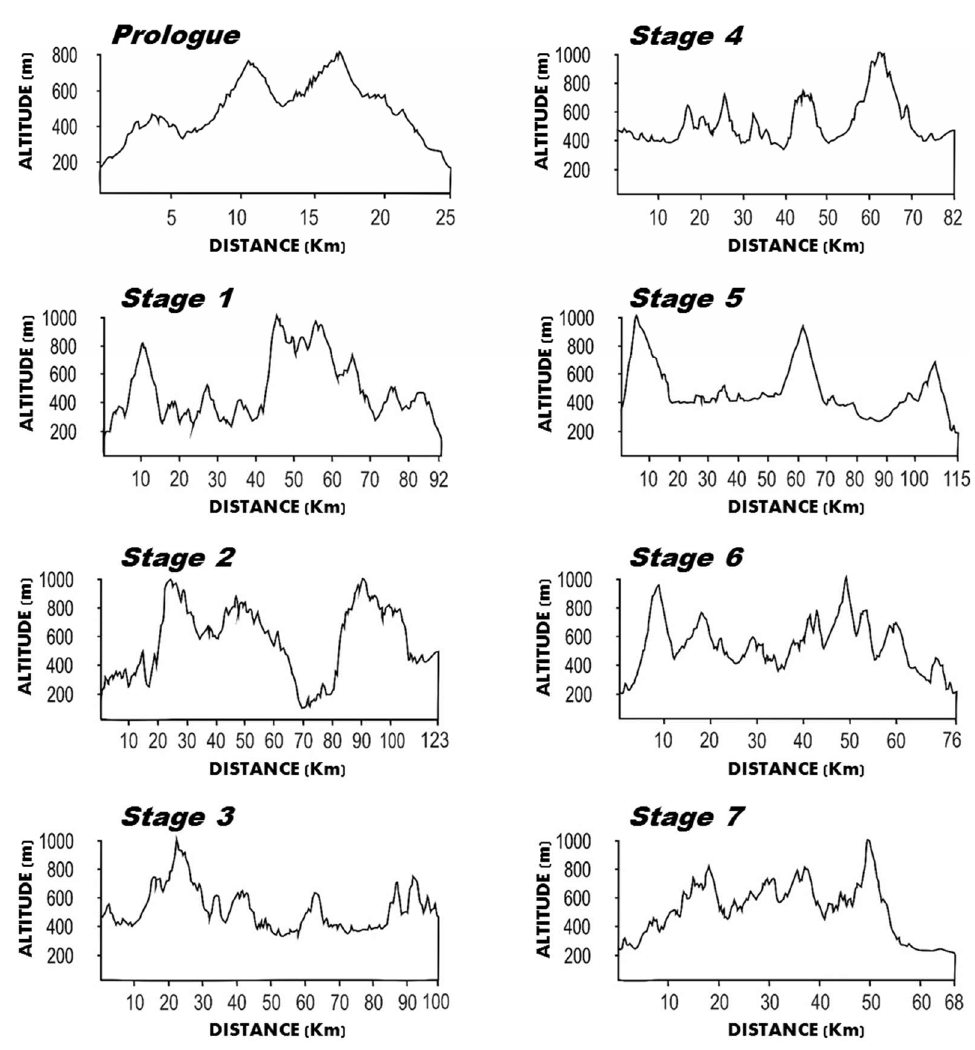
Figure 2. Characteristics of the Cape Epic event.